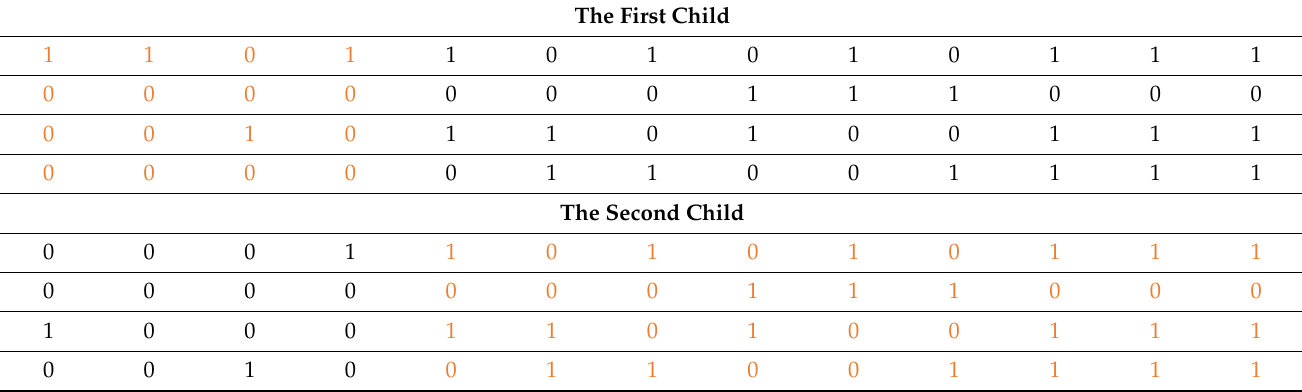
Table 9. Children of the linear (vertical) cross